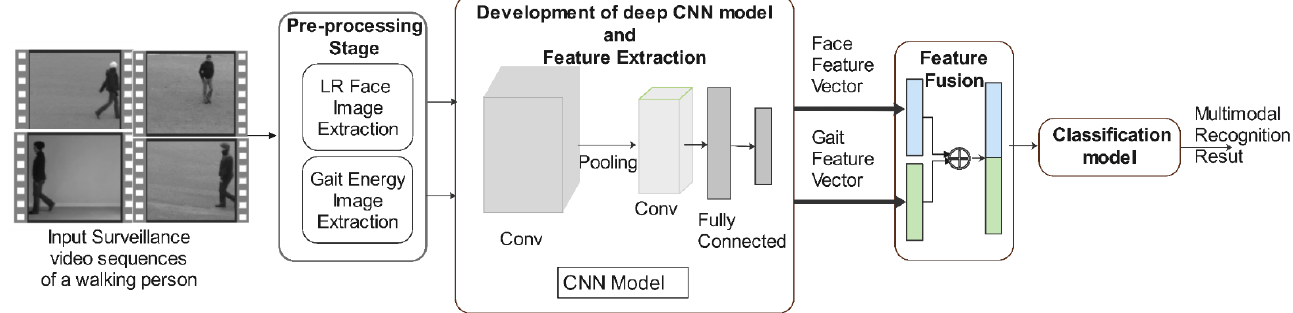
Figure 1. General structure of the proposed multimodal biometrics system.